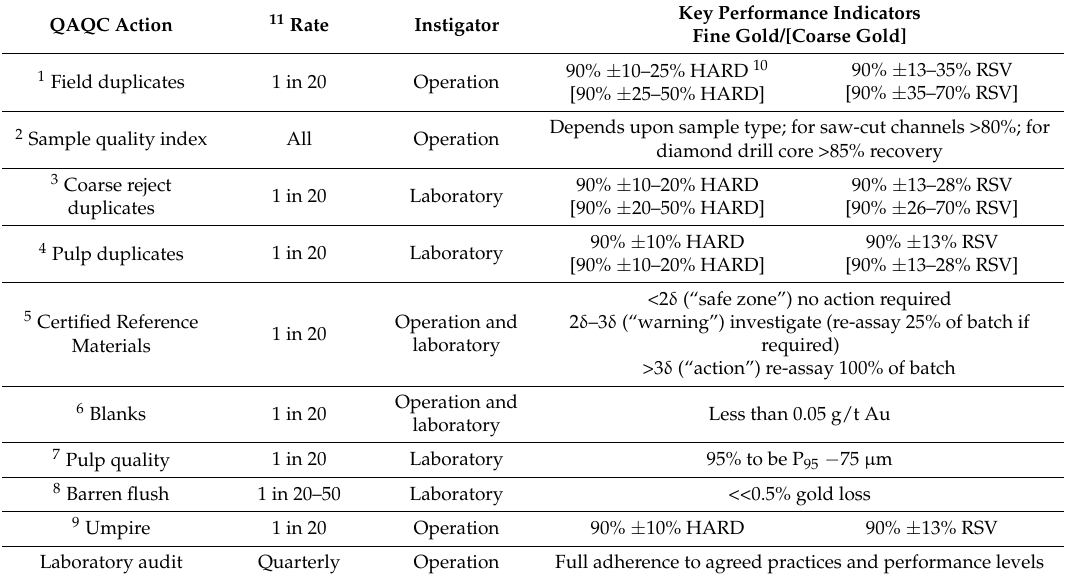
Table 21. Best practice QAQC for a grade control sampling programme that informs a resource estimate. QAQC Action 11 Rate Instigator